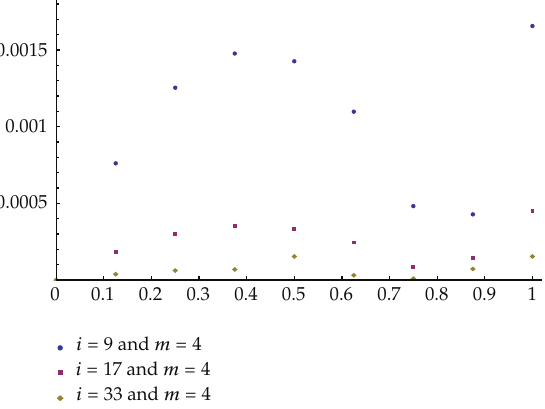
Figure 1: The plot of absolute errors by our method for Example